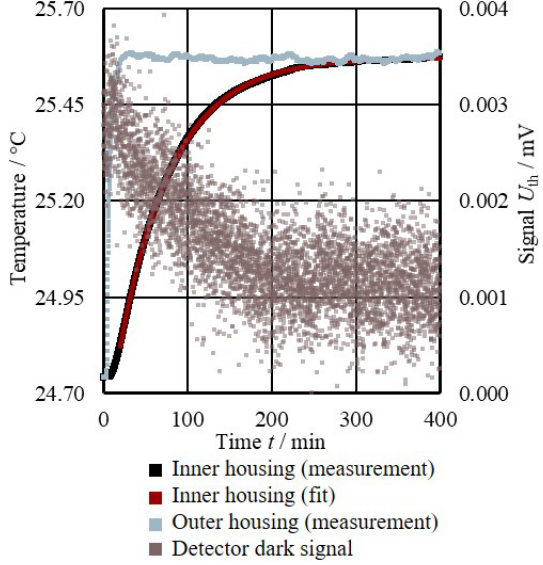
Figure 12. Temperature of the TS-76 measured at the outer hous- ing with the Pt100 and at the inner housing with the thermistor. The outer housing temperature has been increased by about 0.8K with the temperature control system at t = 0min. Furthermore, the de- tector dark signal, which correlates with the temperature of the in- ner detector, and an exponential fit of the measurement of the inner housing temperature are depicted.